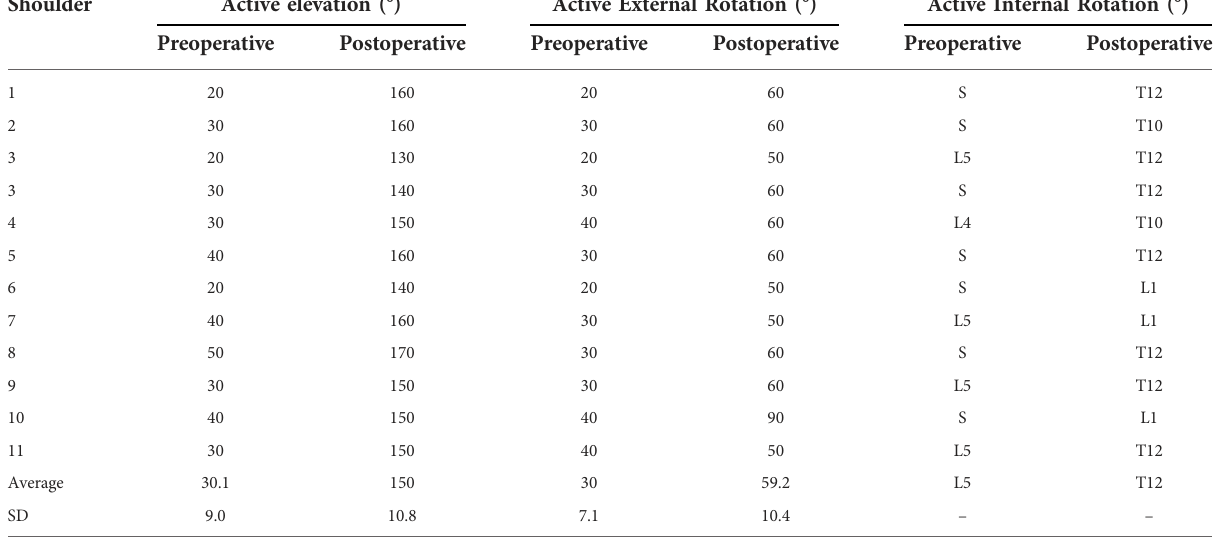
TABLE 3 Summary of patients ’ shoulder range of motion.